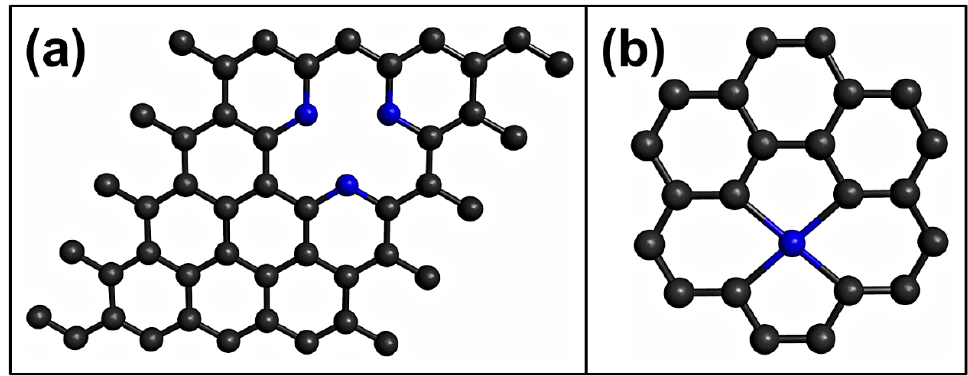
Figure 5. ( a ) Pyridinic-type N-doped graphene, ( b ) doped vacancy-defected graphene. Black and blue spheres represent C and H atoms, respectively.